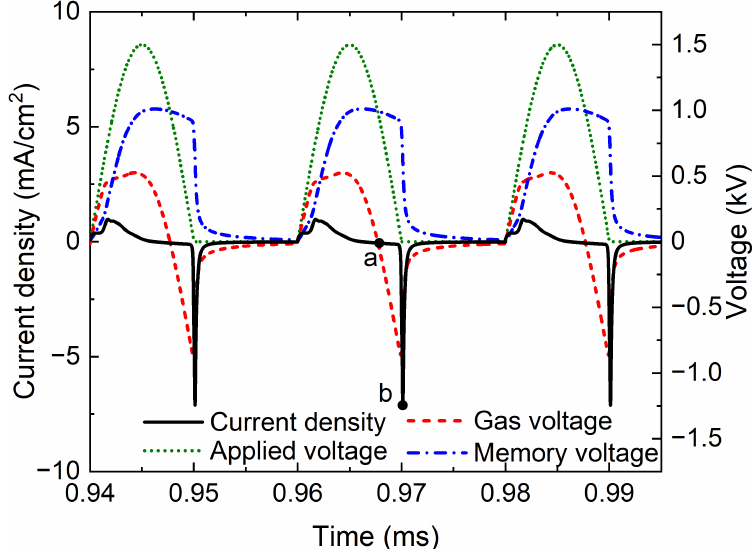
Figure 11. Temporal evolutions of the current density, applied voltage, gas voltage, and memory voltage in RP1 discharge with a gap width of 5.16